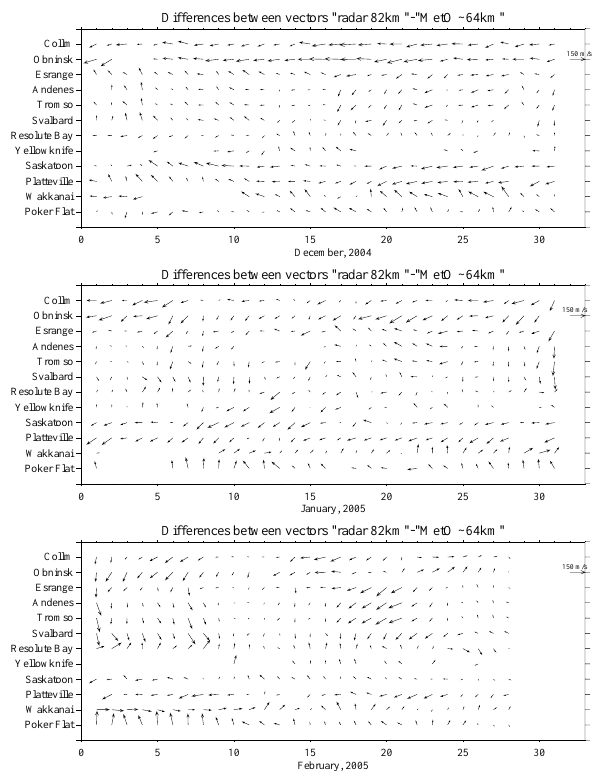
Fig. 9. Vectors of differences between radar winds measured at 82km and MetO assimilated winds at ∼ 64km for 3 months of win- ter of 2004/05 (December, January, and February) for 12